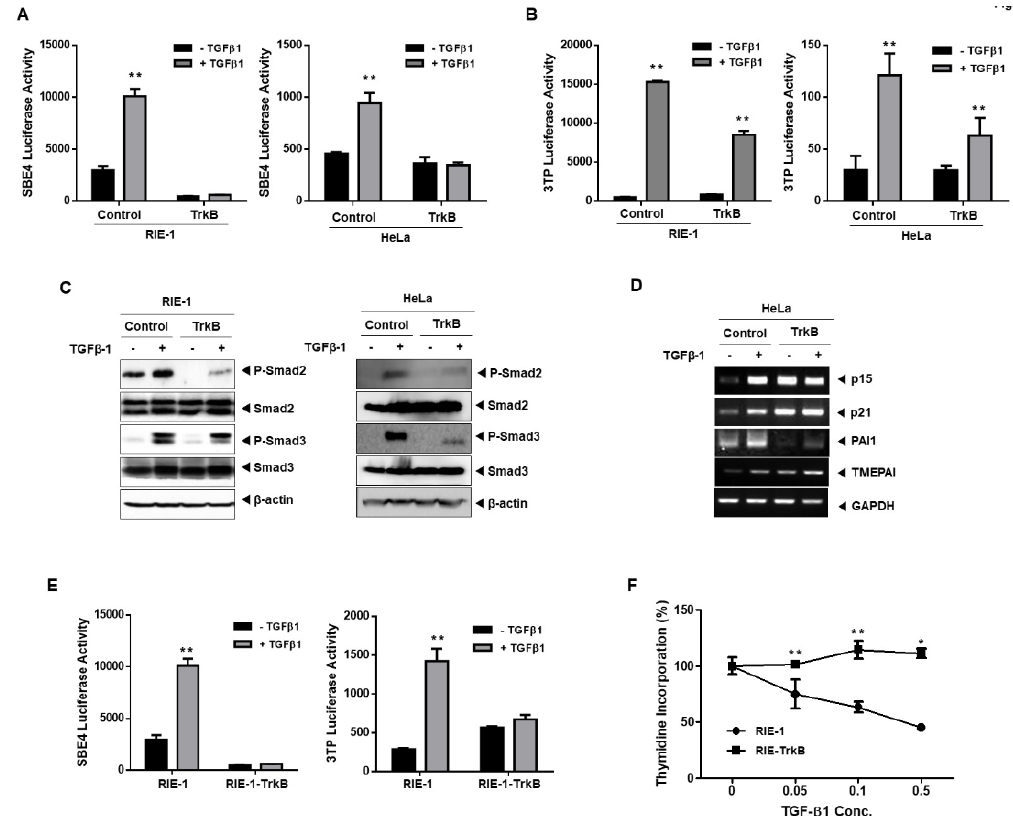
Figure 1. TrkB overexpression inhibits TGF- β -mediated tumor suppressor activity. ( A , B ) The activity of TGF- β 1-responsive SBE ( A ) or 3TP ( B ) luciferase reporter in RIE-1 and HeLa cells transfected with the TrkB. Luciferase activity was measured 24 h after treatment with TGF- β 1 (5 ng / mL). ** Control versus treatment with TGF- β 1, p < 0.05. n = 3. ( C ) Western blot analysis of the expression of phospho-SMAD2, phospho-SMAD3, SMAD2, and SMAD3 in RIE-1, HeLa, RIE-1-TrkB, and HeLa-TrkB cells after stimulation with TGF- β 1 (5 ng / mL). ( D ) RT-PCR analyses of p15Ink4b, p21Cip1, PAI1, and TMEPAI mRNAs in HeLa-TrkB cells after treatment with or without TGF- β 1 (5 ng / mL). ( E ) Luciferase reporter assay of TGF- β 1-responsive SBE or 3TP in RIE-1 or RIE-1-TrkB cells. ** Control versus treatment with TGF- β 1, p < 0.05. n = 3. ( F ) Thymidine incorporation assay of RIE-1 or RIE-1-TrkB cells treated with various concentrations of TGF- β 1 as indicated. Points, averages of means from three determinations; bars, SD. * Control versus treatment with TGF- β 1, p < 0.03. n = 3. ** Control versus treatment with TGF- β 1, p < 0.05. n = 3.